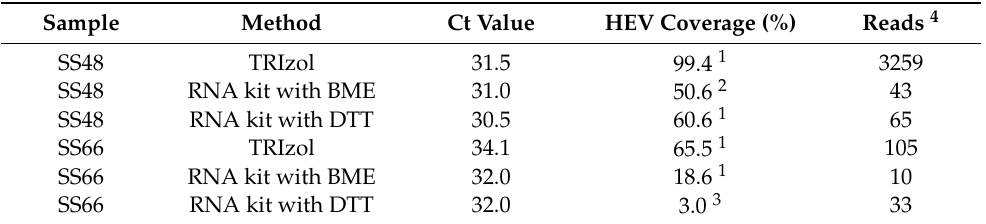
Table 6. Summary of the results from the next-generation sequencing (NGS) of HEV from two sock swabs.